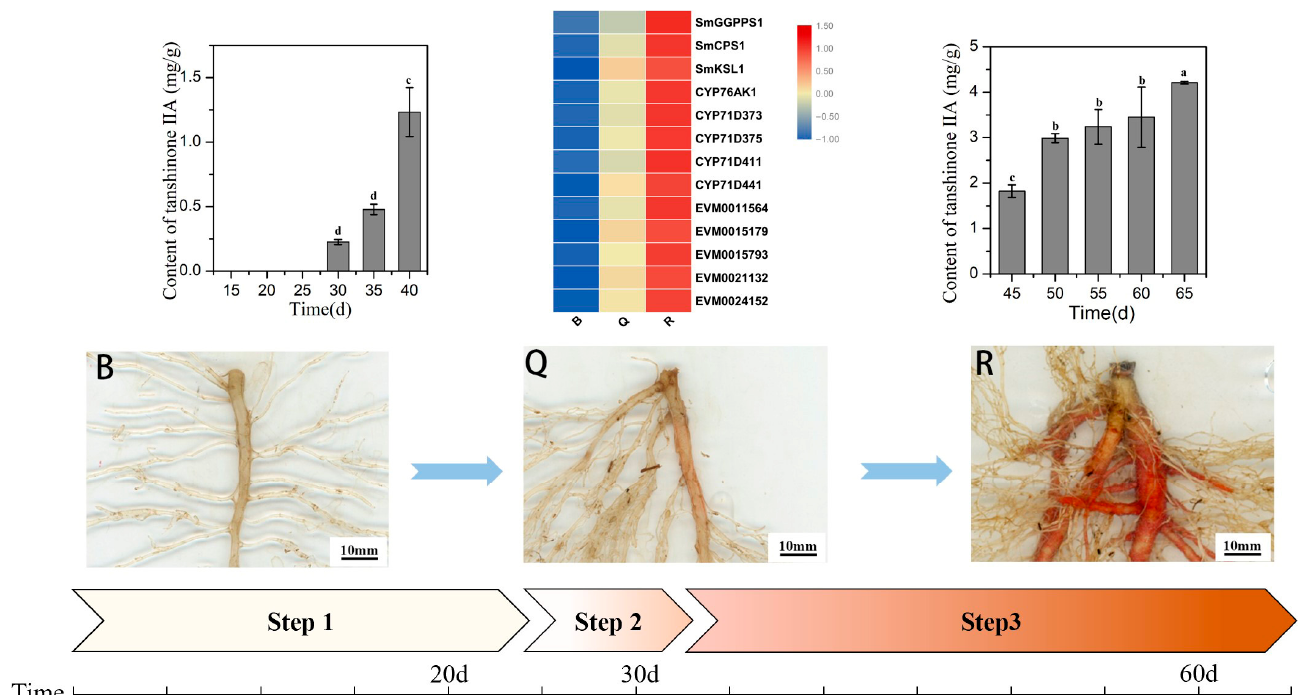
Figure 7. Schematic diagram of the initial synthesis process of tanshinone. B represent the white root, Q represent the light red root, R represent the red root, Step 1 represent the preparation stage, Step 2 represent the initial synthesis stage, and Step 3 represent the rapid accumulation stage. Different letters in bar chart (a, b, c, d) indicate significant differences ( p ≤ 0.05) according to Waller-Duncan’s